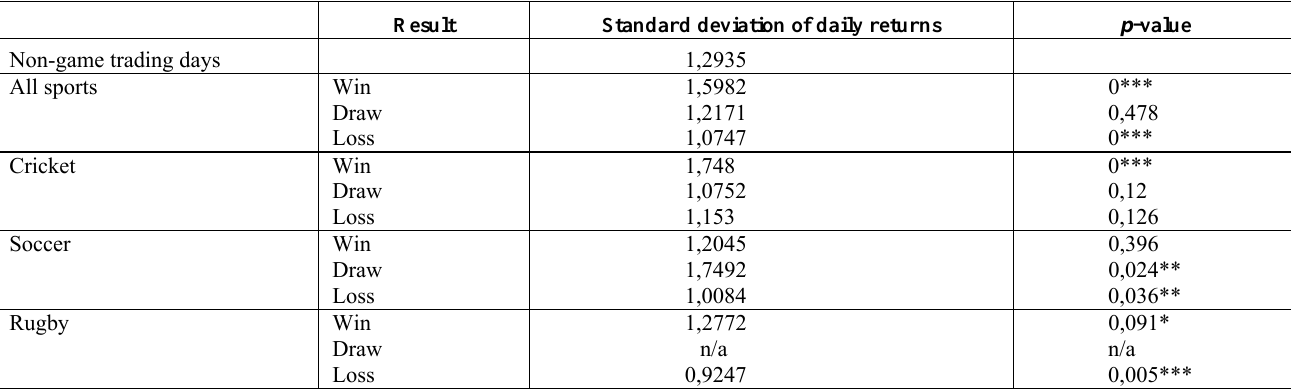
Table 7: South African sports results and stock market volatility